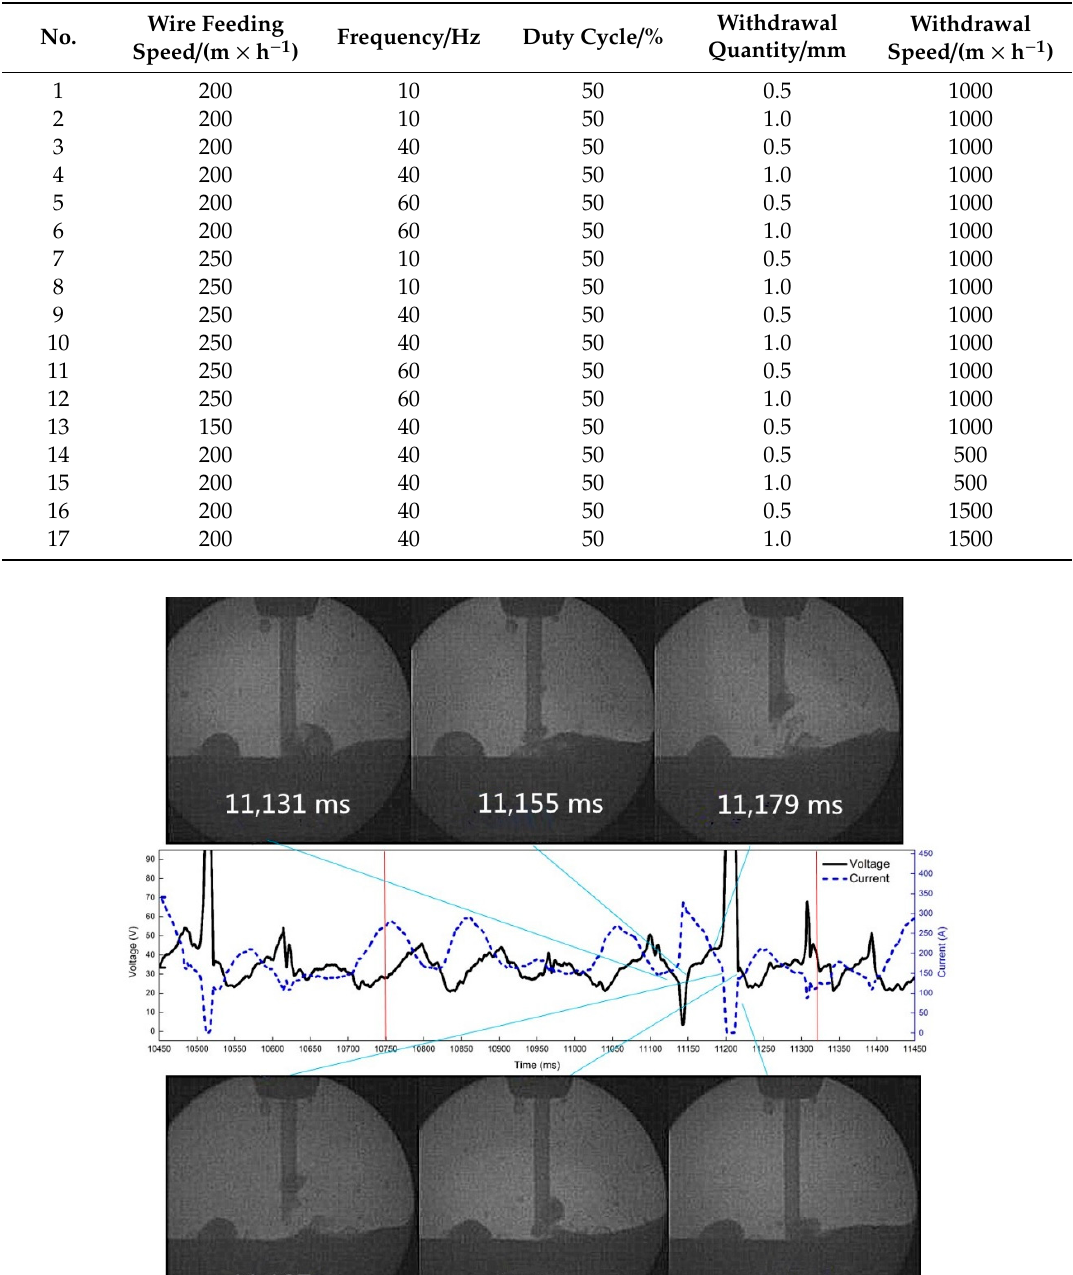
Table 2. Experimental group parameters of the pulsating wire feeding mode.